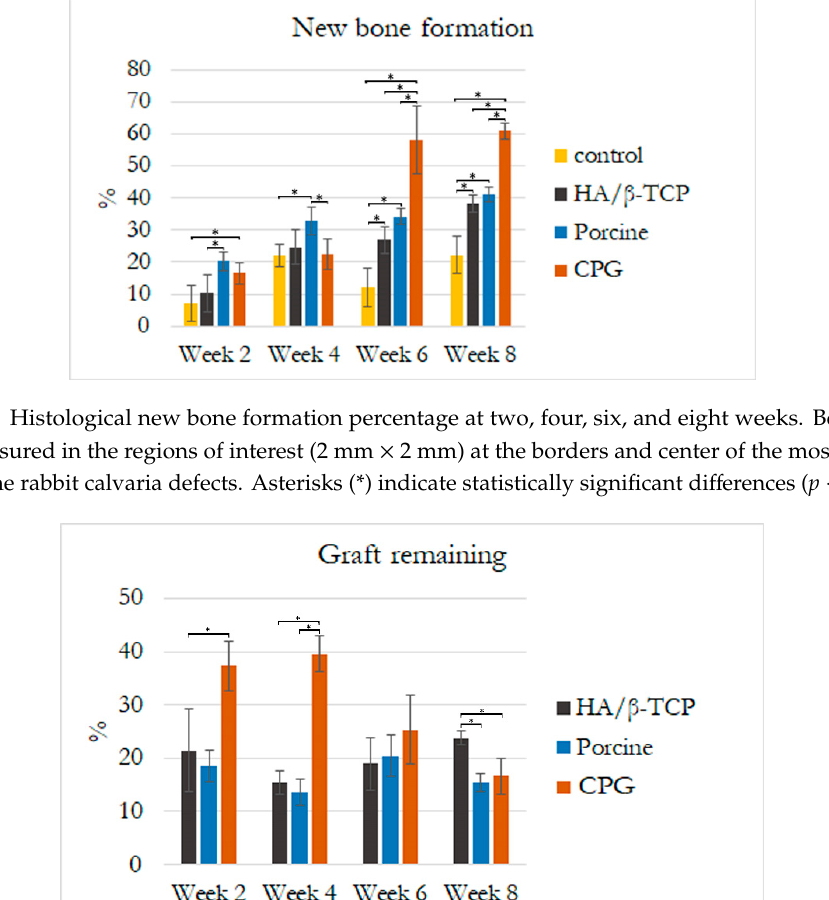
Figure 8. Histological graft remaining percentage at two, four, six, and eight weeks. Graft particle area